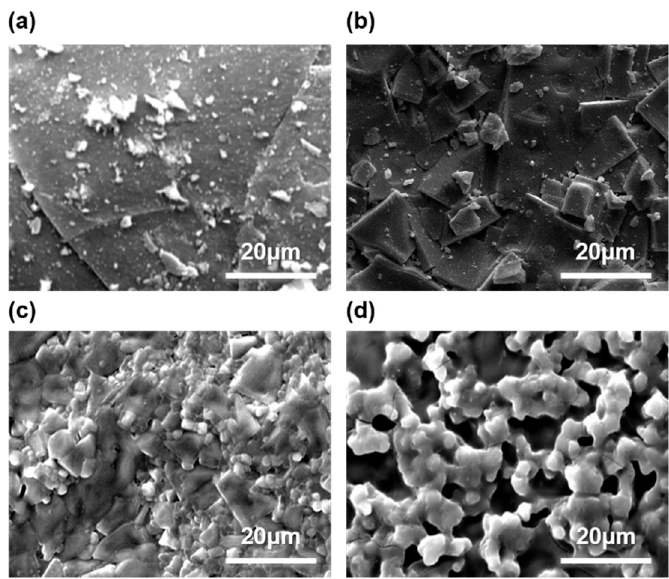
Figure 6. SEM micrograph of citric acid-assisted powder ( a ), EDTA-assisted powder ( b ), citric acid- assisted disk surface ( c ), and EDTA-assisted disk surface ( d ) treated at 1100 °C for 3